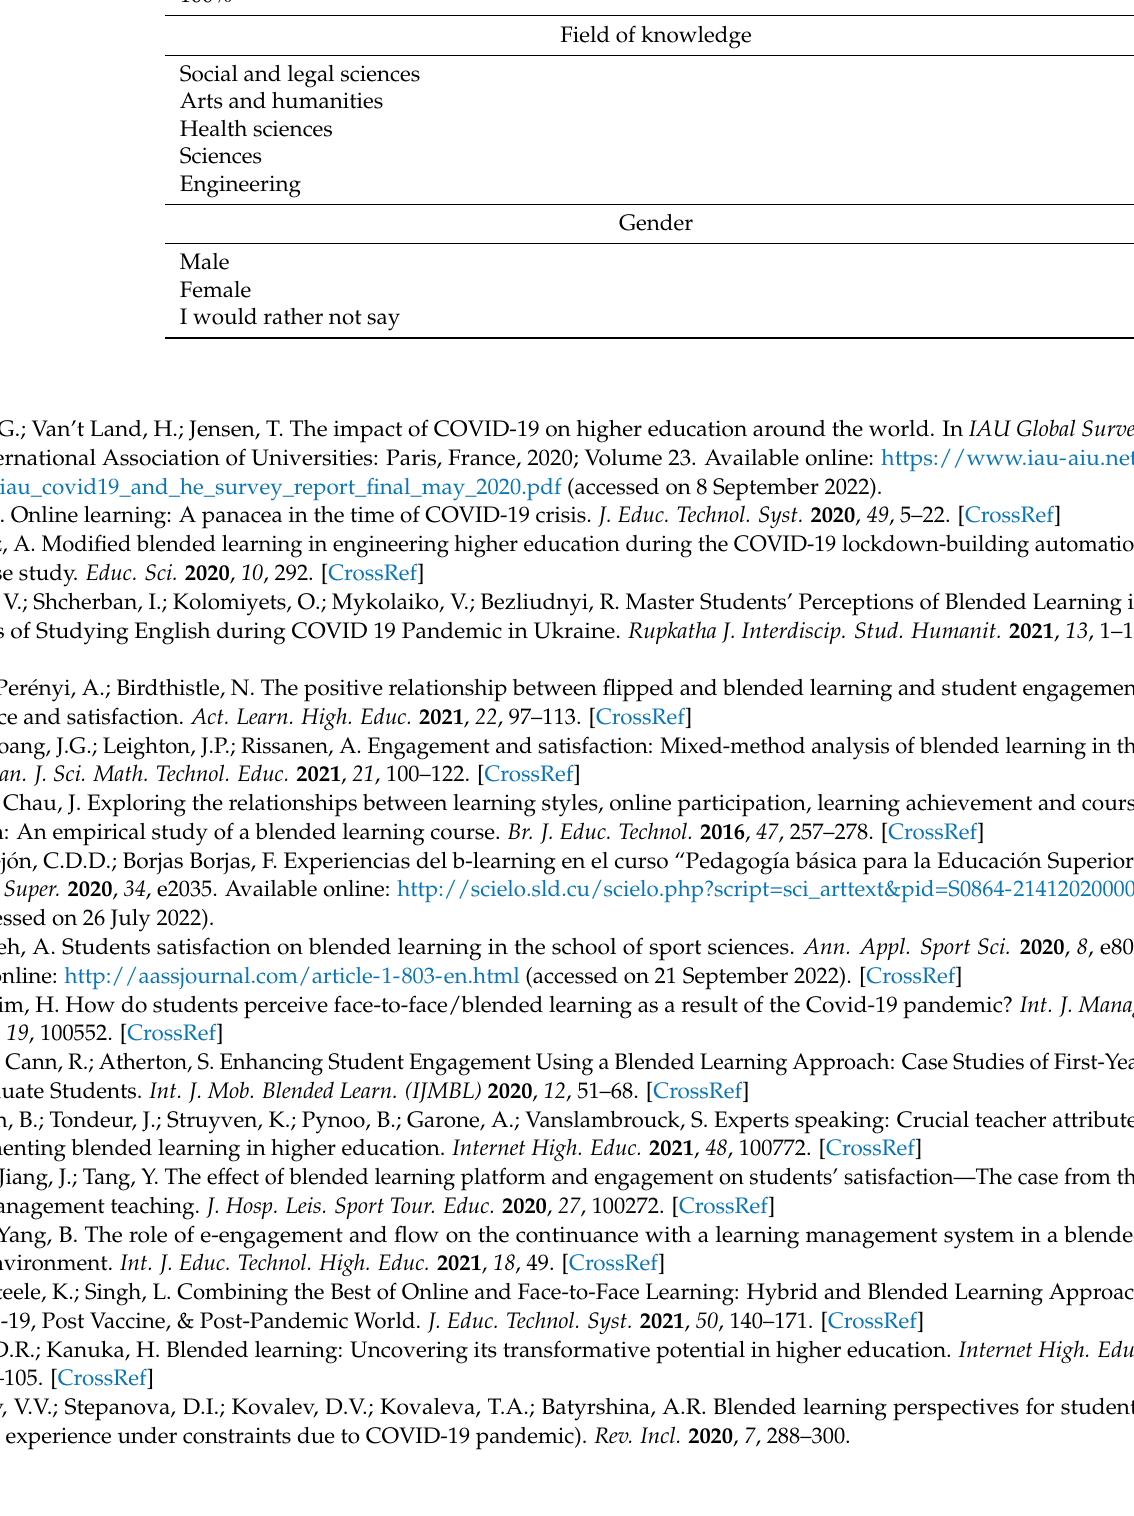
Your Experience in Blended